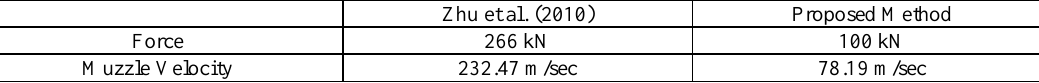
Table 2. Comparison of results with the existing method (Octapole